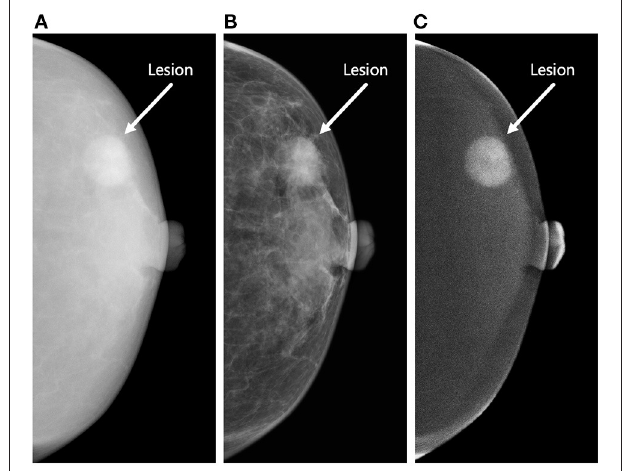
FIGURE 1 | Three types of contrast-enhanced mammography (CEM) images of the craniocaudal view. The figure demonstrates a round-shaped lesion (white arrow) in the outer quadrant of the left breast of a 63-year-old woman. Biopsy revealed invasive ductal carcinoma (Grade II, Luminal A subtype). The lesion was correctly classified as malignant by the proposed radiomics model constructed by the combination of high-energy (HE), low-energy (LE), and dual-energy subtraction (DES) images. (A) The HE image of CEM. This type of image is not used for clinical diagnosis. (B) The LE image of CEM. This type of image is considered to be equivalent to conventional mammography. (C) The DES image of CEM. This type of image can highlight areas of contrast enhancement. The lesion shows marked enhancement in this image, whereas the patient shows minimal degree of background parenchymal